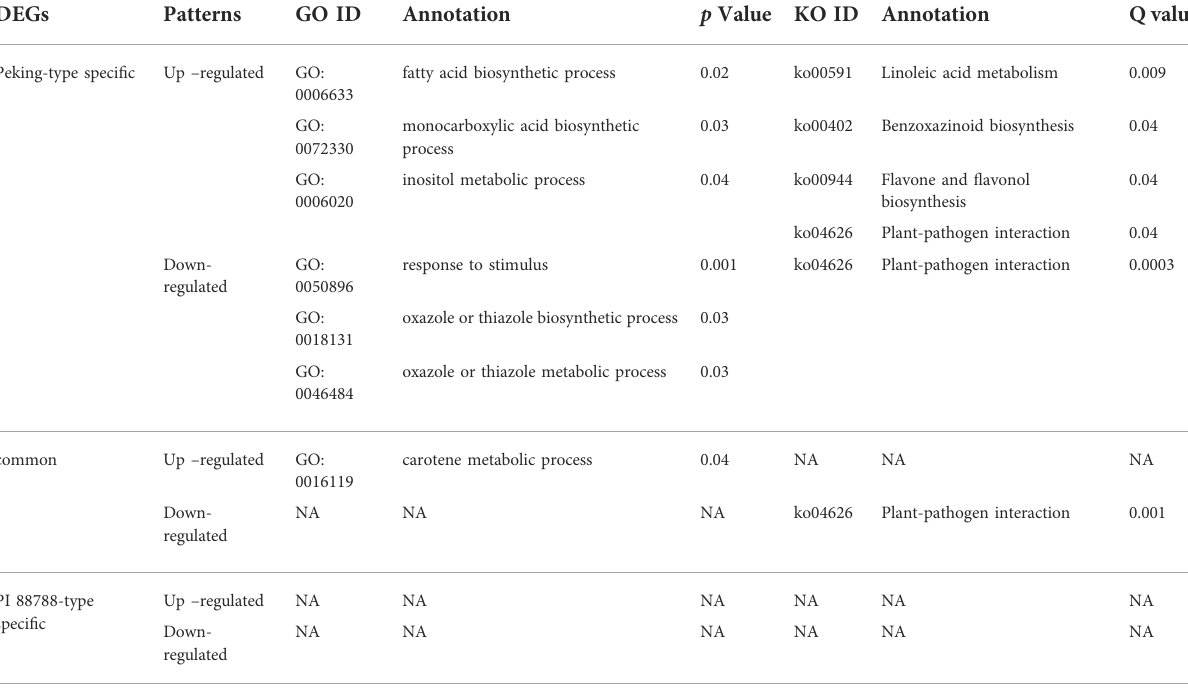
TABLE 2 The biological process ontology andpathway analysis of differentially expressed genes (DEGs)between Peking- and PI 88788-type sources of resistance (Pool-I and Pool-II).